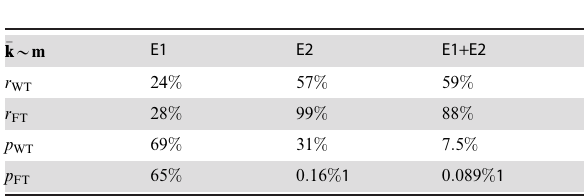
Table 5. Correlation r WT = FT between slope and mean intra- subject stiffness and its probability p and E2.